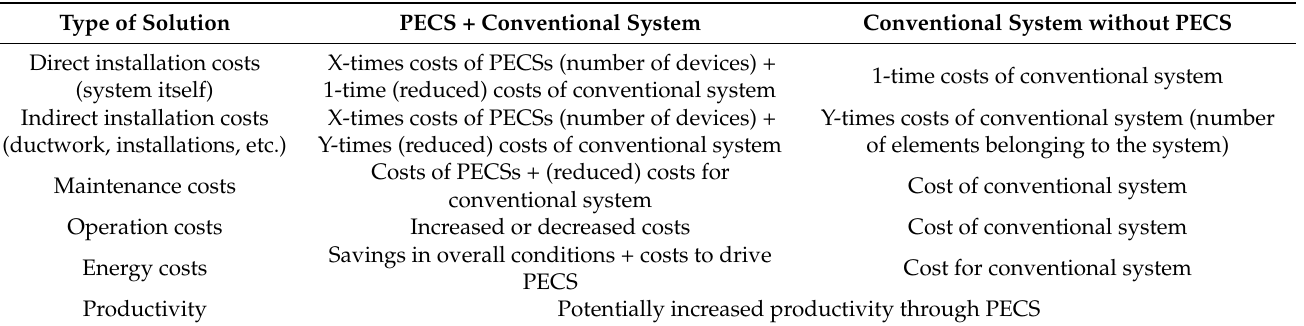
Table 2. Proposed framework for assessing the cost-effectiveness of a PECS solution combined with a conventional system. Adapted from [14].